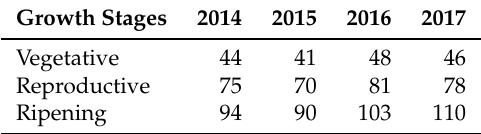
Figure 1. Demonstration of biochar and nitrogen treatments. The field was treated with three nitrogen rates (N0, N1 and N2) and four biochar rates (C0, C1, C2 and C3). Table 1. Day after transplantation (DAT) on which the data collection campaigns were